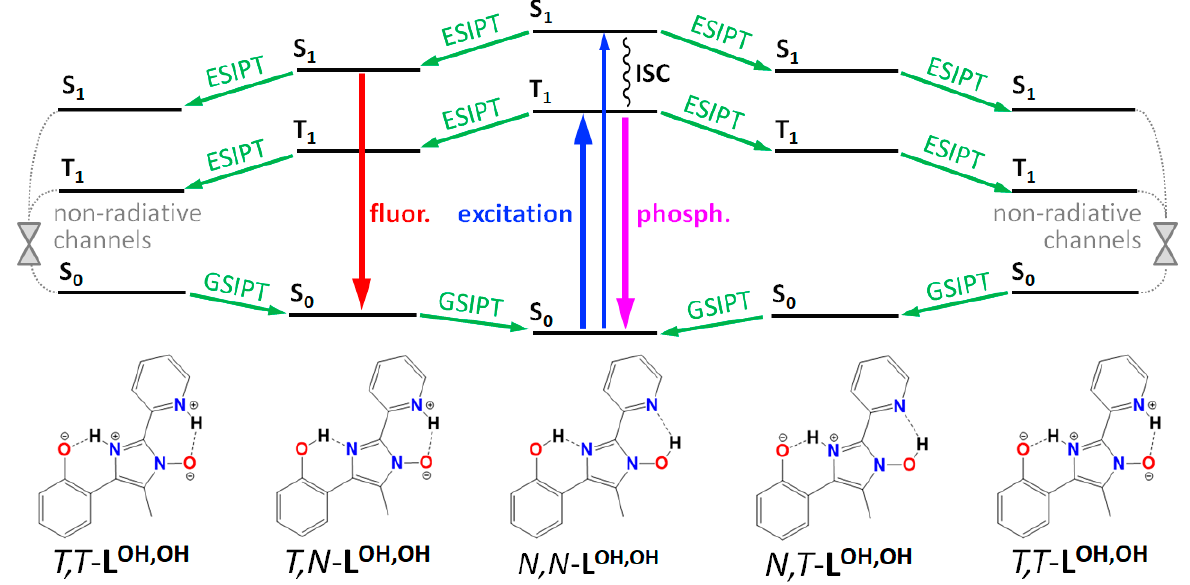
Figure 11. Photophysical and photochemical properties of L OH,OH in the solid state summa- rized in a simplified energy level diagram. ISC—intersystem crossing, phosph.—phosphorescence;